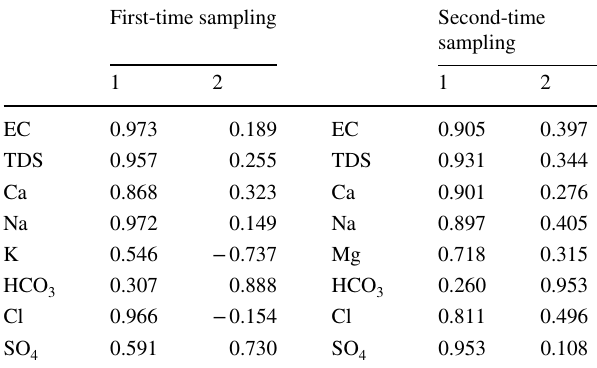
Table 5 Rotated component matrix for studied parameters in the lake and downstream of the Gotvand-e-Olya